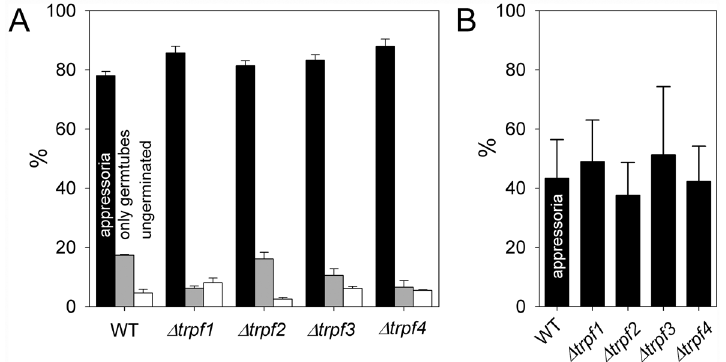
Fig 5. Germination of C . graminicola spores on (A) polystyrene and (B) onion epidermis. Black: germ tubes with appressoria, grey: germ tubes without appressoria, white: ungerminated conidia. On onion epidermis, only appressoria were counted. Data are means ± SE (N = 3; > 100 spores per replicate).